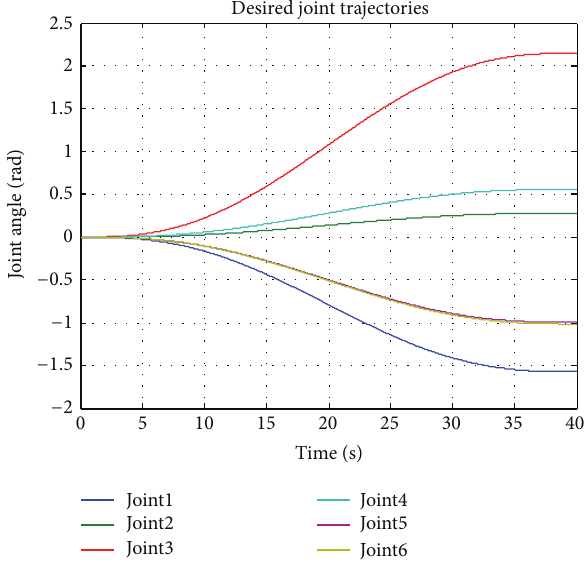
Figure 9: Desired joint trajectories for the dynamic simulation.